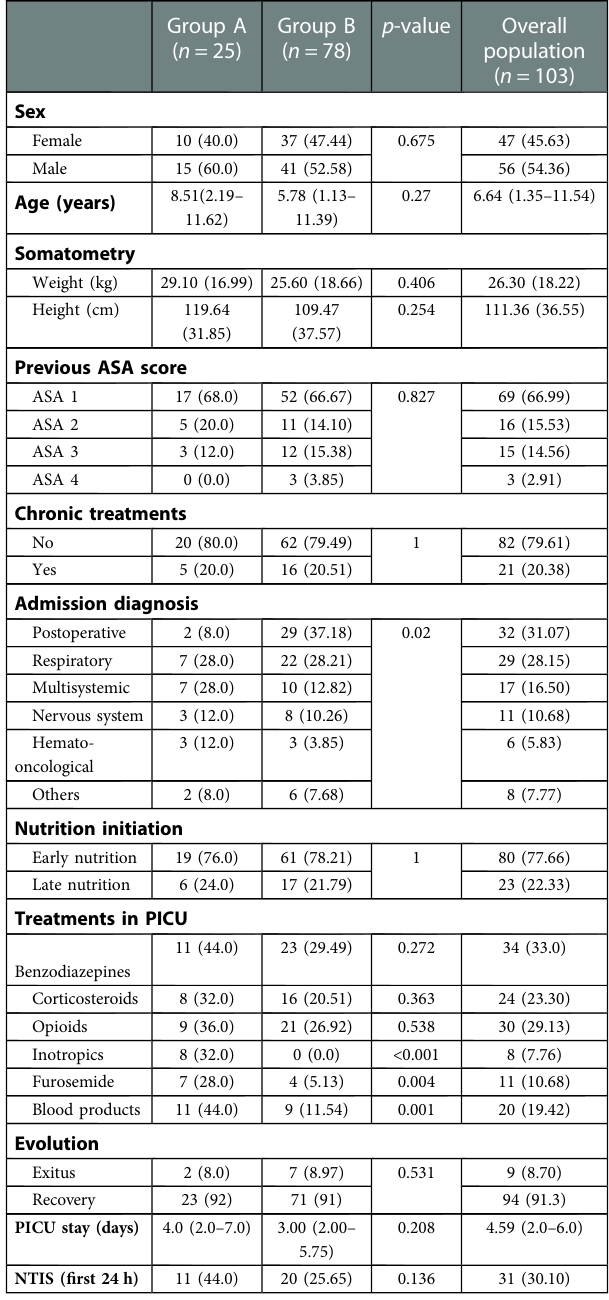
Group A: Higher score risk mortality group. Group B: Lower score risk mortality group. Weight and height are described by average (standard deviation); Age and PICU stay are described by median (P25 – P75); the rest of variables are described by the absolute and relative values (%). Nutrition initiation refers to both enteral and parenteral; Early: started in the fi rst 24 h of admission; Late: started